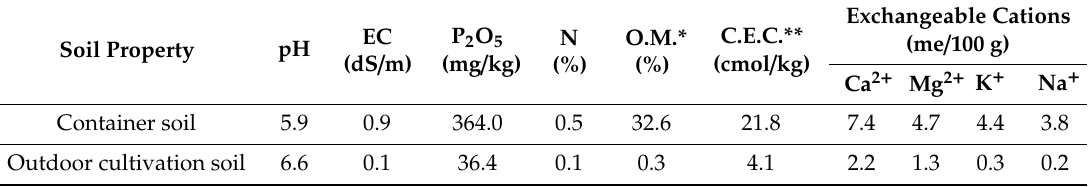
Table 2. Soil properties of the seedlings used for experiments.